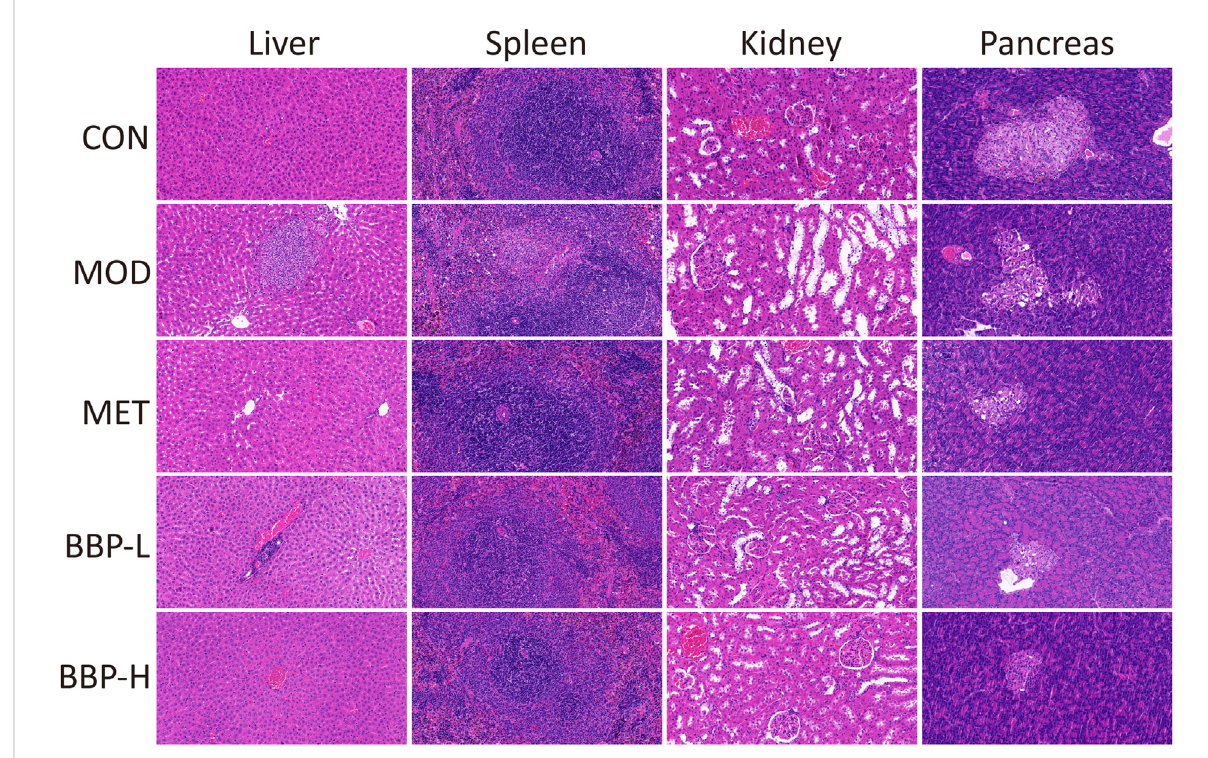
The effects of BBP on histopathology (HE staining × 20) of liver, spleen, kidney and pancreas in